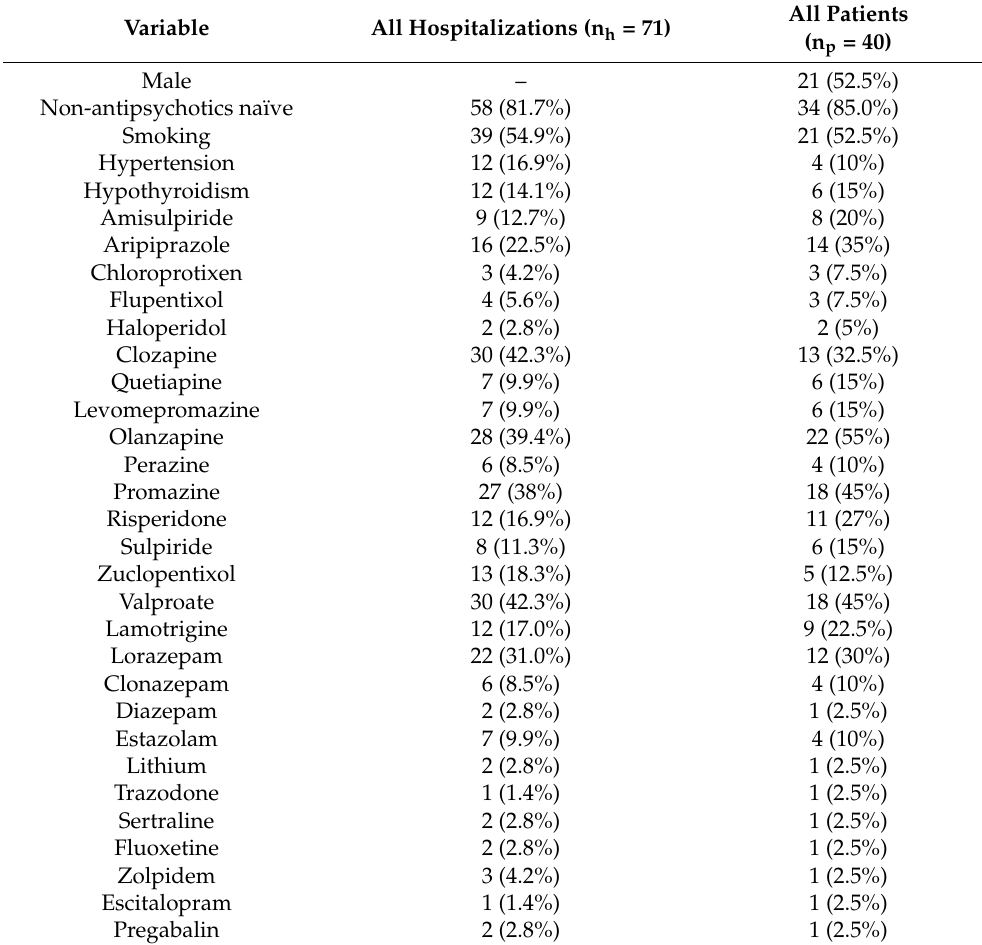
Table 2. The frequencies of the categorical variables included in the study and the number of hospitalizations during which the patient was taking the given antipsychotic